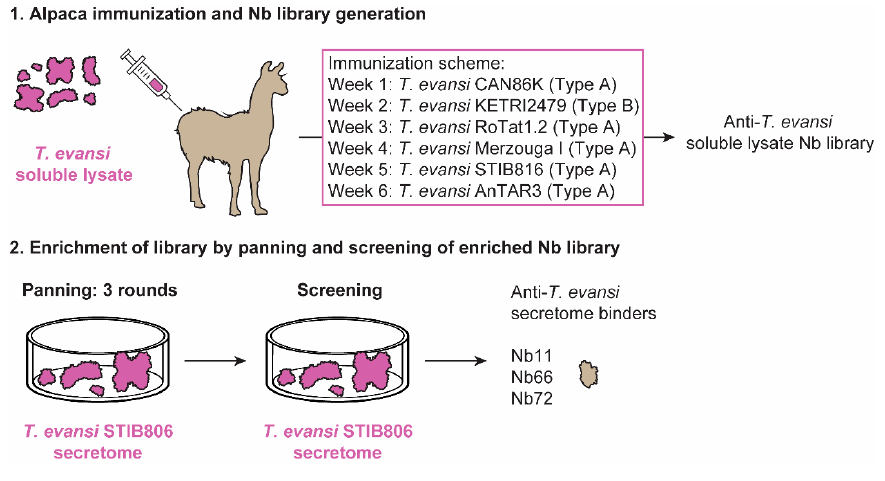
Figure 1. Schematic overview of the construction of the anti- Trypanosoma evansi lysate Nanobody (Nb) library. The anti- T. evansi lysate Nb library was generated from an alpaca that was sequentially immunized with T. evansi soluble lysates from six different strains (CAN86K, KETRI2479, RoTat 1.2, Merzouga I, STIB816, and AnTAR3) ( 1 ). Phage panning was performed on a secretome preparation from T. evansi STIB806 for three consecutive rounds. Single colonies from each round were screened for potential binders recognizing T. evansi secretome components ( 2 ).